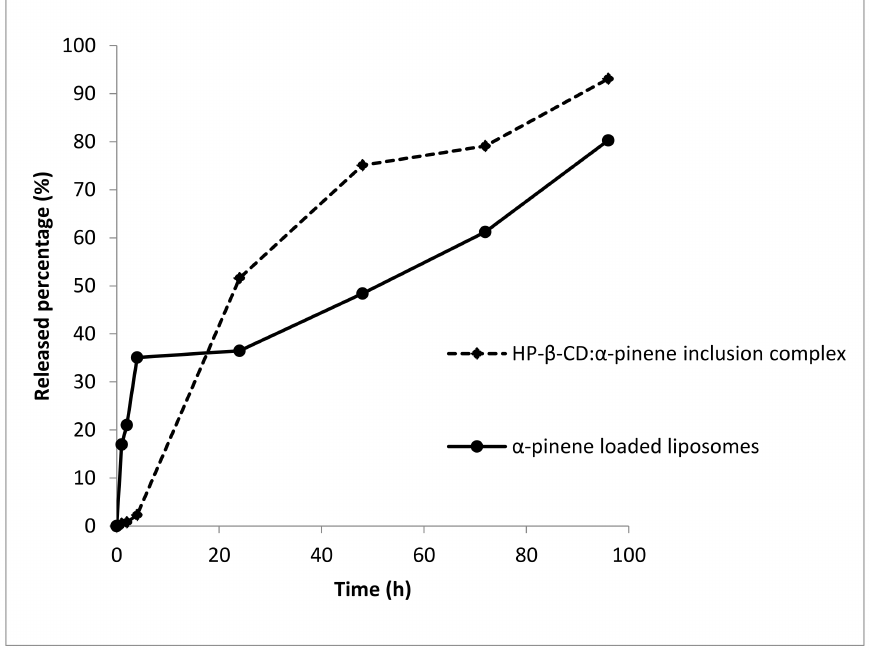
Figure 3. The in vitro release profile of α -pinene from HP- β -CD: α -pinene inclusion complex and from Lipoid S-100